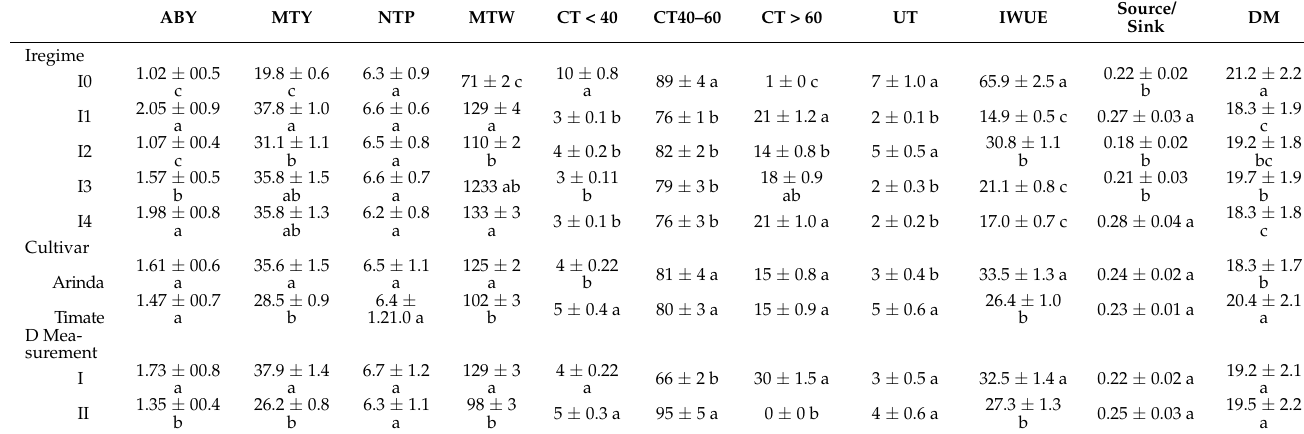
Table 6. Above-ground Biomass Yield (ABY, t DW ha − 1 ), Marketable tuber yield ((MTY, t FW ha − 1 ), Number of tubers (NTP, N plant − 1 ), Mean Tuber Weight (MTW, g), caliber tubers (CT, %), unmarketable tubers (UT, %), Irrigation Water Use Efficiency (IWUE, kg FW m − 3 ), source/sink ratio and tuber dry matter (DM, %) as affected by the main factors.